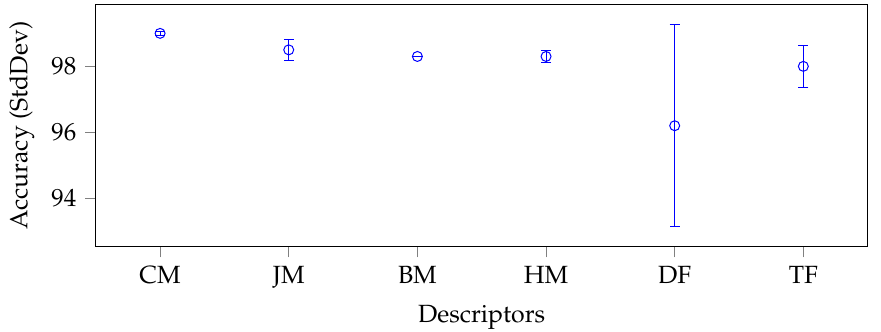
Figure 5. Average accuracy and standard deviation calculated on each descriptor category with the best classifier on average, for the Axial OASIS-MRI data set.